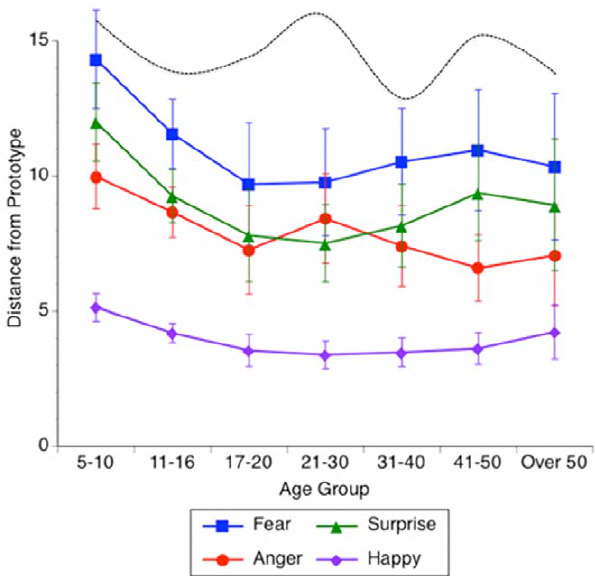
Figure 3. Emotional Experience Effects are Consistent Across Age Groups. Absolute value of the distance from the prototypical expression for all emotions across age groups. Data show mean and 95% confidence intervals. Dashed line indicates the distance from the prototypical expression of fear from those who report having experienced ‘Very Weak’ fear in their